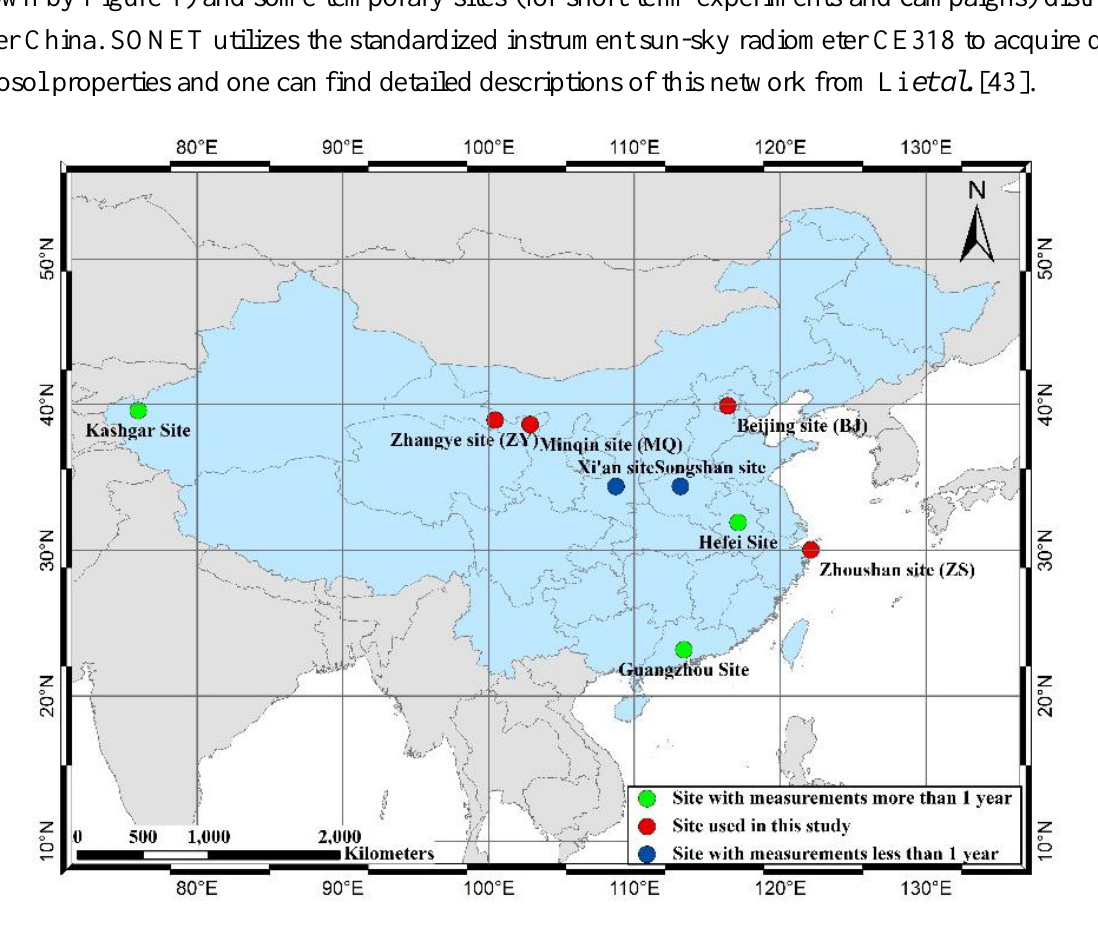
Figure 1. Locations of SONET observation sites. The three sites with measurements taken for more than one year (green dot) are not investigated in this study because of their proximity to the selected sites (red